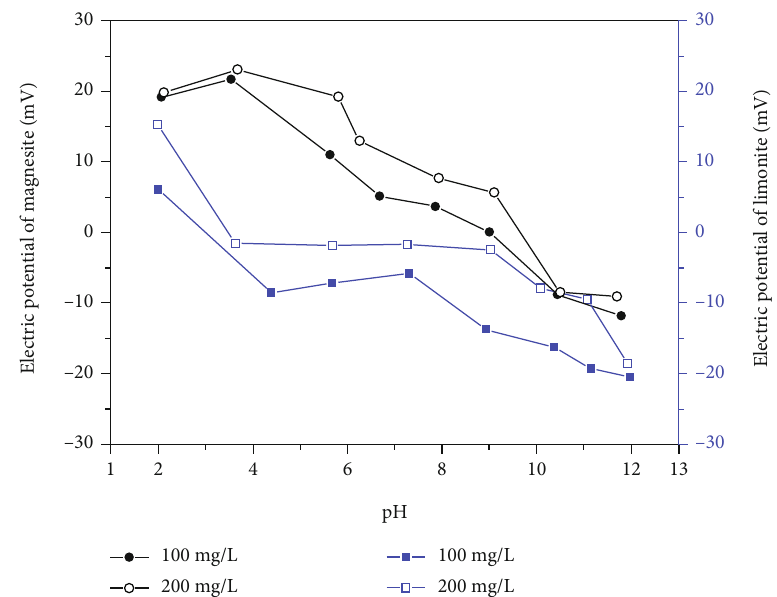
Figure 11: E ff ect of KD on zeta potential of magnesite and